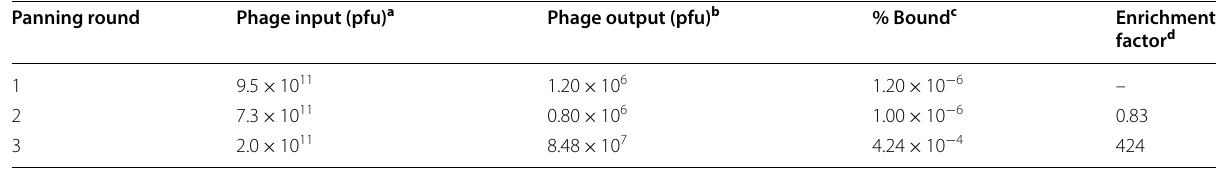
a Number of phage pfu incubated with the antigens immobilized on the nitrocellulose strip b Number of phage pfu eluted after the incubation above c Percentage of bound phage calculated as the ratio phage output/phage input d Ratio of the percentage of bound phage at round n vs the percentage of bound phage at round n–1